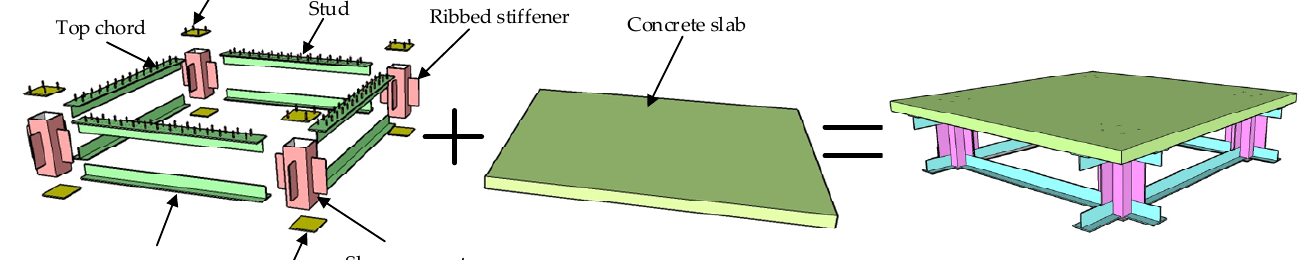
Figure 1. Physical model diagram of Vierendeel sandwich plate.